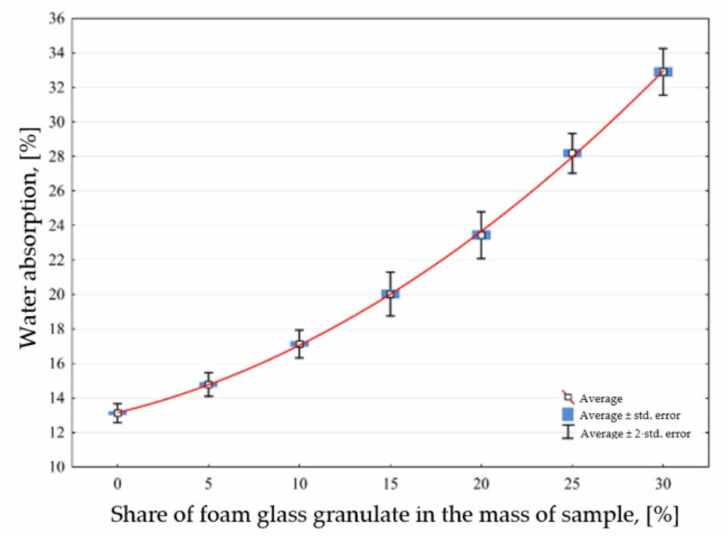
Figure 2. Effect of GFG fraction 0.25–0.5 mm weight of the sample to the water absorption of the final